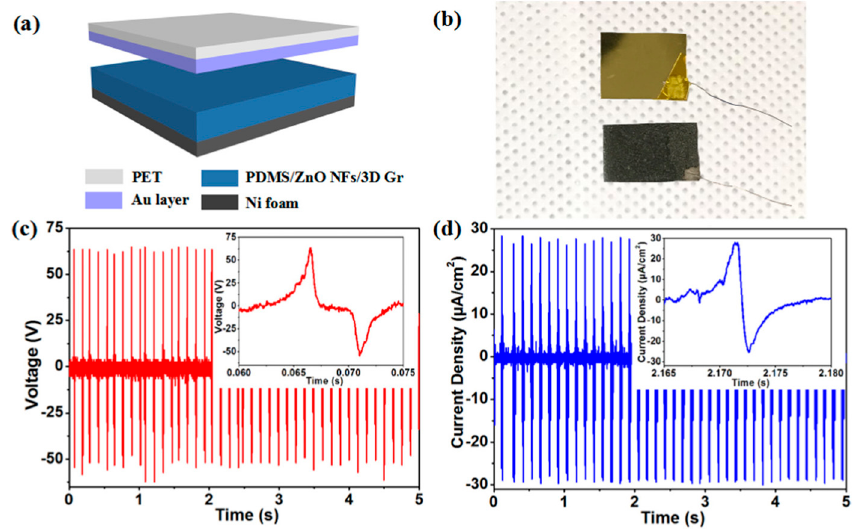
Figure 7. ( a ) Schematic structure of a PENG based on ZnO nanoflakes. ( b ) Image of an actual device. ( c ) Open-circuit voltage of PDMS/ZnO NF/3D Gr/Ni foam-based PENG. ( d ) Short-circuit current density of PDMS/ZnO NF/3D Gr/Ni foam-based PENG [108]. Reprinted with permission from Yang et al. (2018). Copyright © 2018 American Chemical Society.